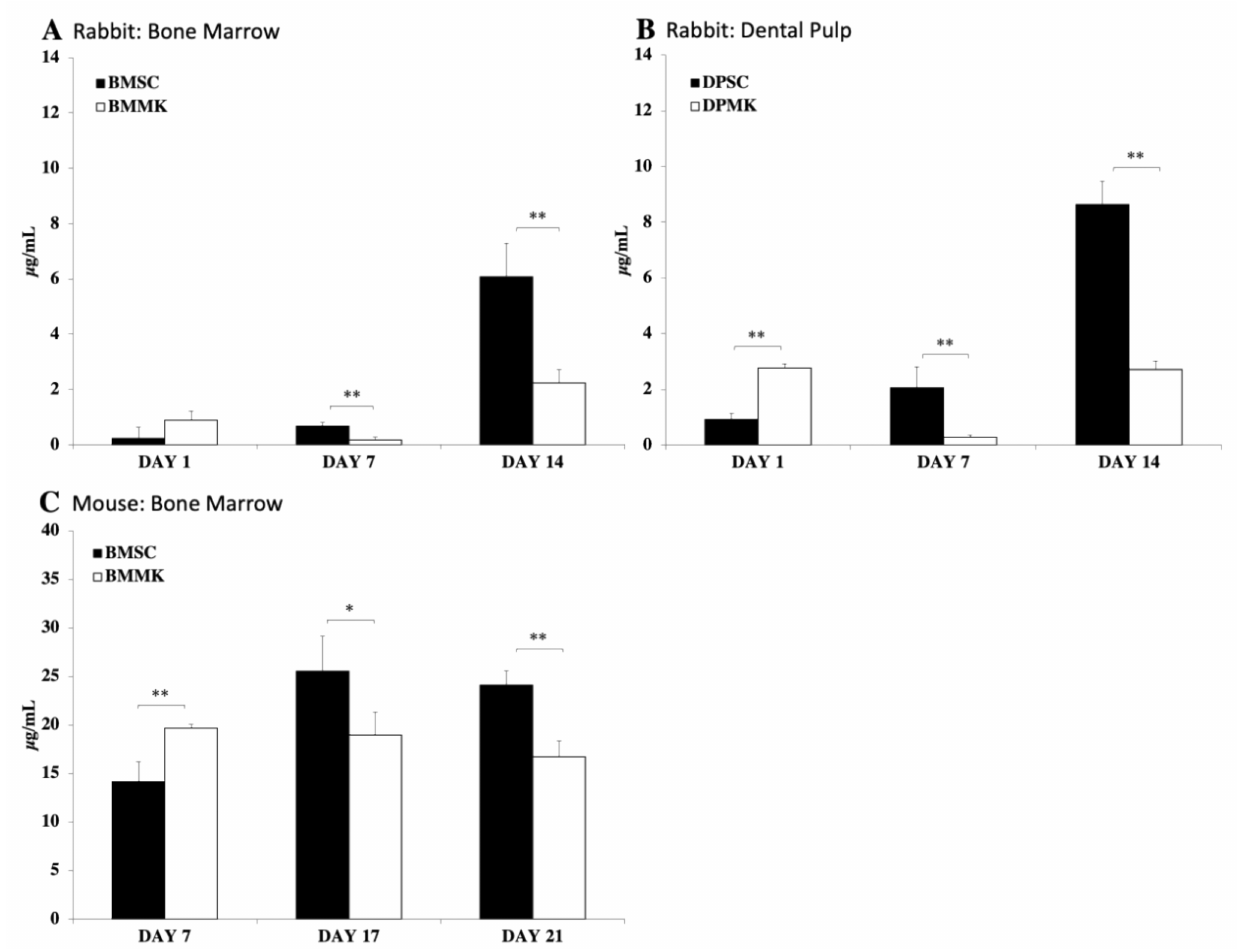
Figure 10. Calcium deposition of MSCs co-cultured with or without MKs. ( A ) shows control group of rabbit BMSCs (BMSCs) and experimental group of rabbit MKs co-culture with rabbit BMSCs (BMMK). ( B ) shows control group of rabbit DPSCs (DPSCs) and experimental group of rabbit MKs co-cultured with rabbit DPSCs (DPMK). ( C ) shows control group of mouse BMSCs (BMSCs) and experimental group of mouse MKs co-cultured with immortalized mouse BMSCs (BMMK). Figure 9A,B shows calcium deposition measured on days 1, 7, and 14, while Figure 9C shows calcium deposition measured on days 1, 17, and 21. Error bars reflect standard deviation of the mean. Significant difference between groups is indicated by error bars: * = p < 0.05 and ** = p < 0.01